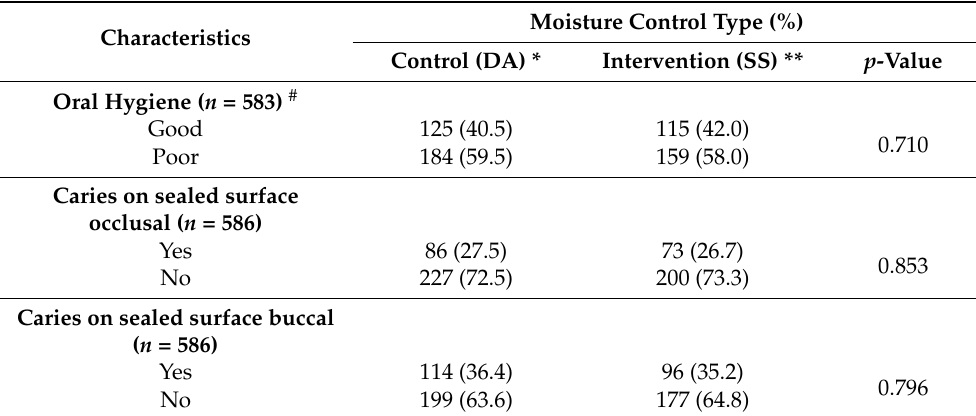
Table 4. Oral hygiene and caries on sealed surfaces of follow-up teeth at 15–18 months by groups (410 children and 586 teeth).